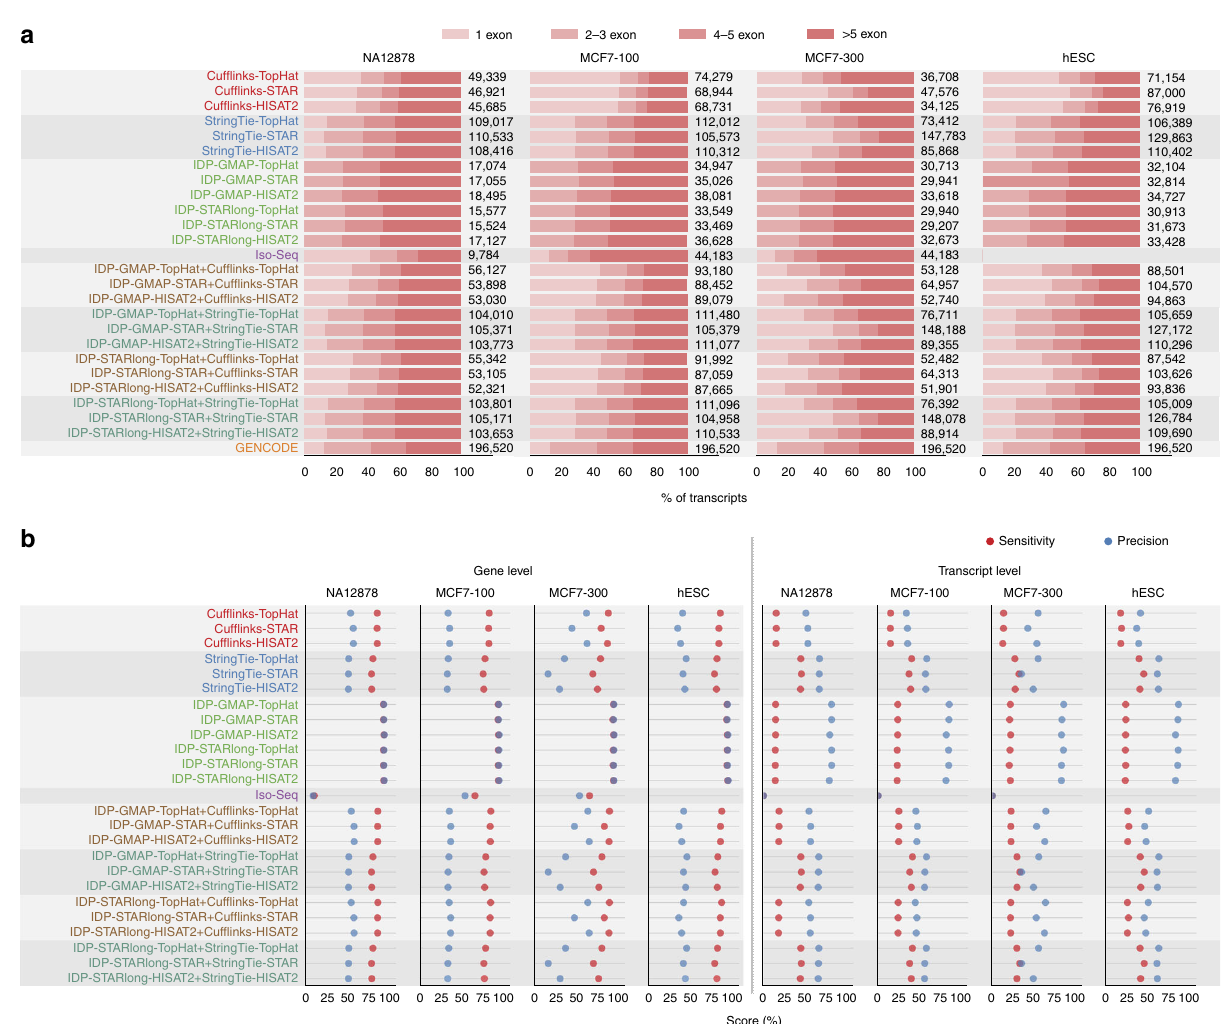
Fig. 3 Performance of different transcriptome reconstruction schemes. a Distribution of number of exons per transcripts for different transcriptome reconstruction algorithms. Labels re fl ect the assembler, the long-read aligner (for IDP), and the short-read aligner used, respectively, with “ - ” separation. b Sensitivity and precision of different transcriptome reconstruction approaches at gene and transcript levels. The GENCODE reference transcriptome annotation is used as the truth set. The evaluations on a more recent update of MCF7 sample using the Iso-Seq pipeline resulted in a similar performance with only slight improvement. The union approaches that combined predictions from short reads and long reads (shown with a “ + ” in the label)